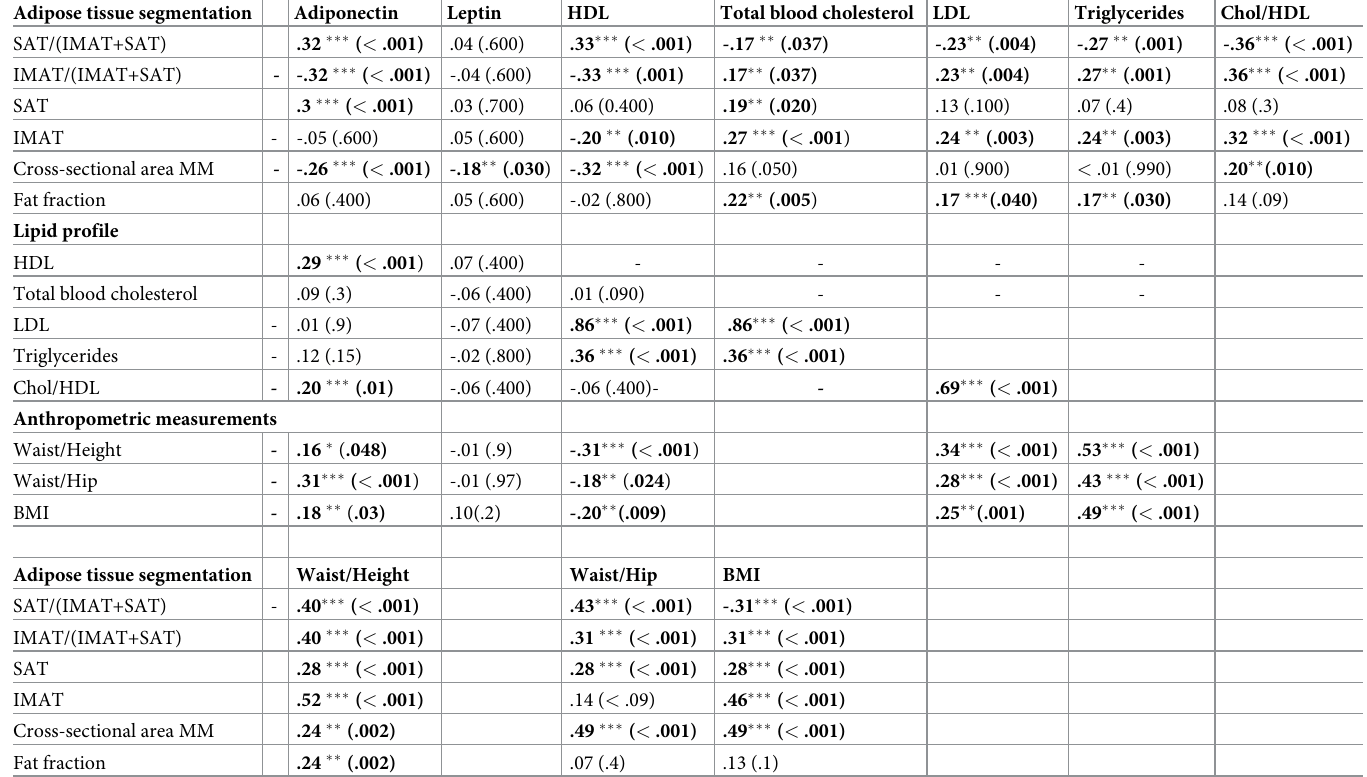
Table 2. Correlation between fat tissue segmentation results, adiponectin, leptin, lipid profile, and anthropometric measurements. Pearson correlation coefficients (r-values) and associated p-values in parentheses are shown. Adipose tissue